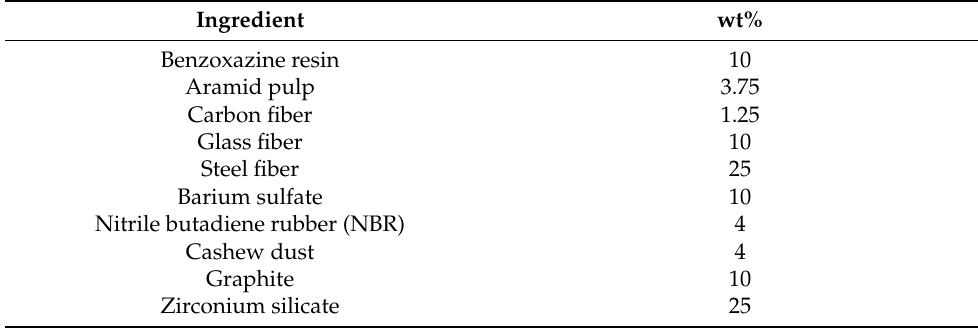
Table 1. Formulation of polybenzoxazine composites for friction